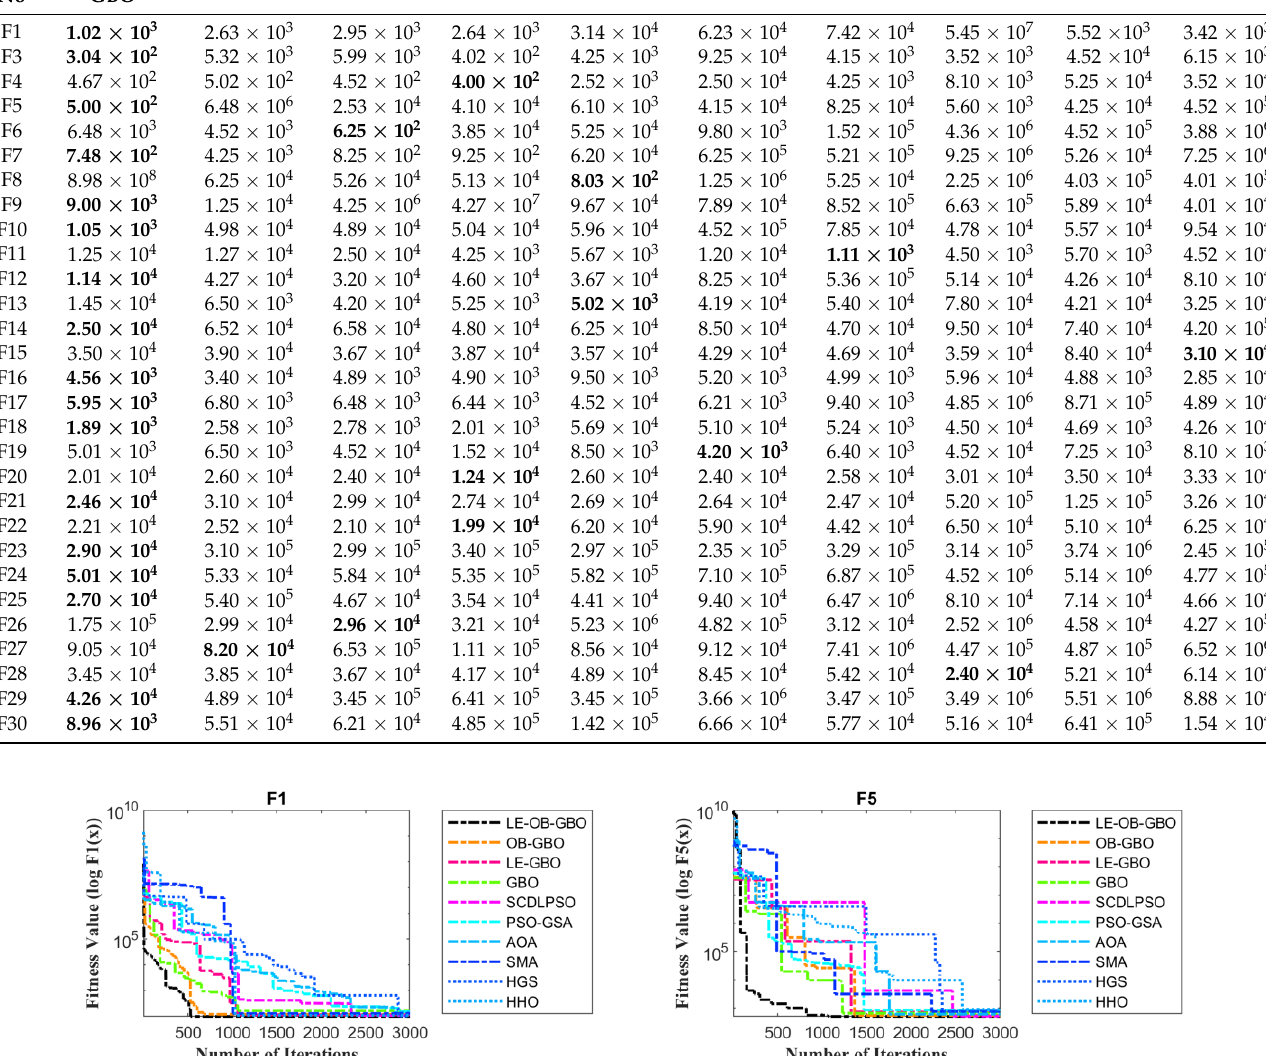
Figure 2. Convergence curve of F1 (unimodal) and F5 (multimodal).